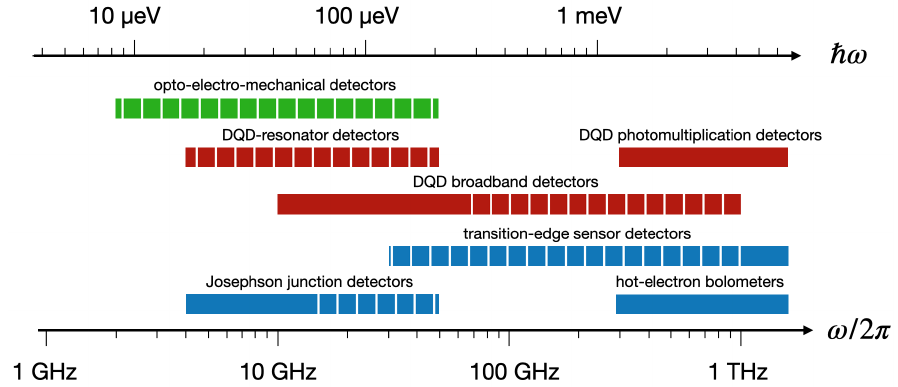
Figure 1. Schematic diagram showing the frequency working range of different photon detectors based on quantum dots (red), superconducting circuits (cyan), and opto-electro-mechanical systems (green). Solid regions show the frequency range of experimentally tested detectors, whereas striped regions indicate possible developments and theoretical